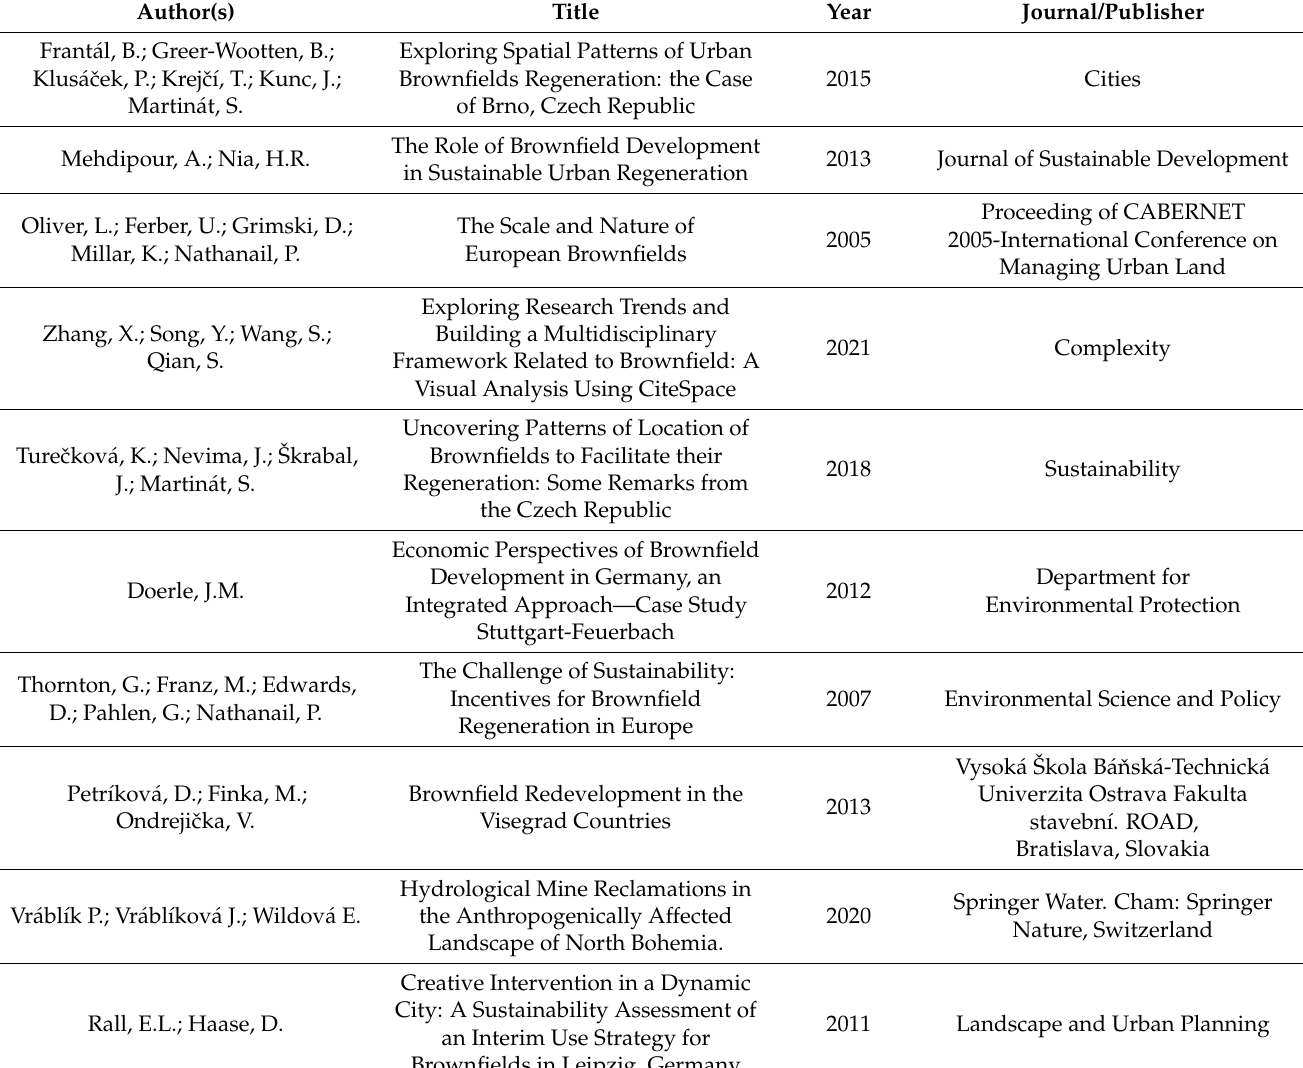
Table 1. Articles selected for analysis in the